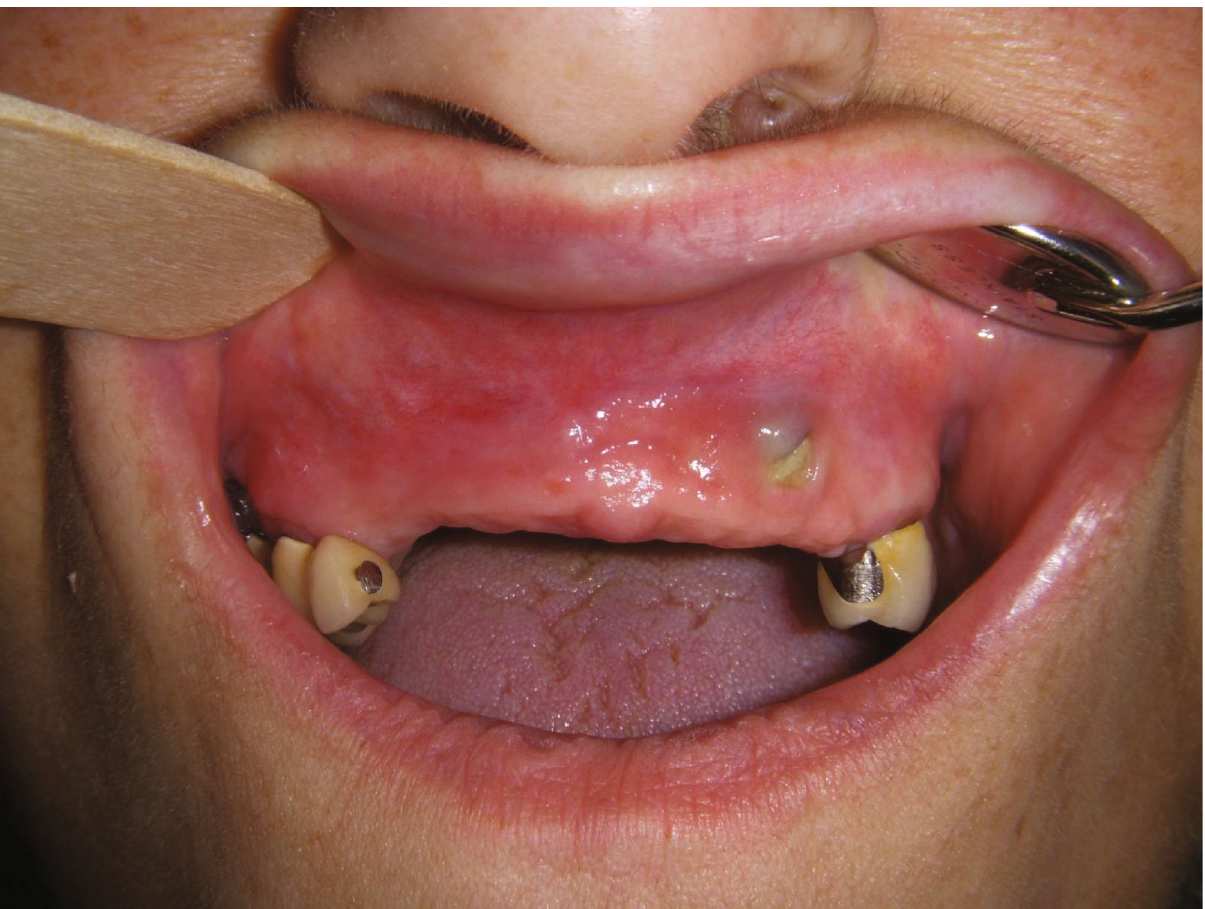
Figure 9: Exposure of the left-placed plate occurred 24 months after surgery (18 months after applying the mobile prosthesis).